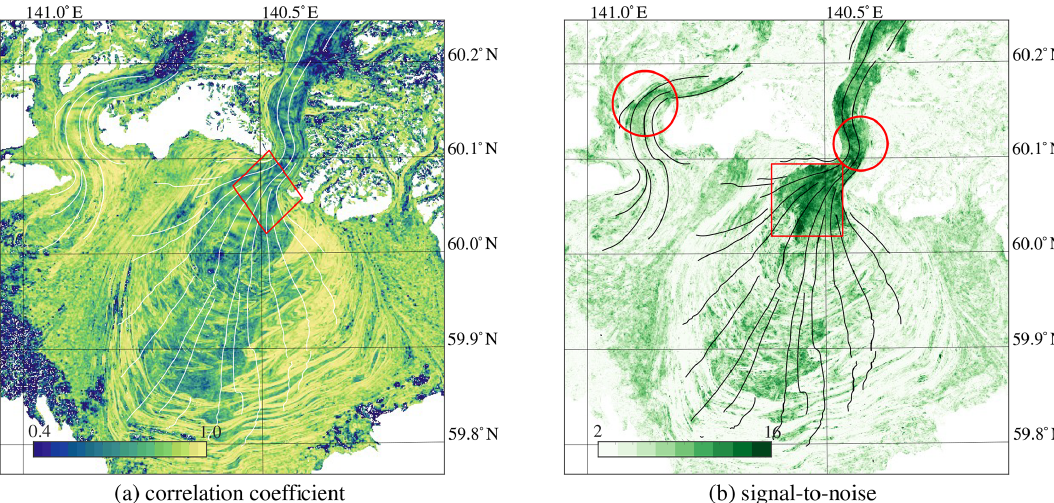
Figure 9. Correlation descriptors over the Malaspina case study showing the absolute correlation value for each match (a) and the signal-to- noise values (b) . The red circles indicate highly distinct regions that align with regions of large shear (Fig. 6a) and many crevasses (Fig. 6b); the red square also indicates a region with high values but has homogenous flow with many surface cracks. The red diamond highlights a pattern that is similar to the integer distance as shown in Fig. 10b, indicating a